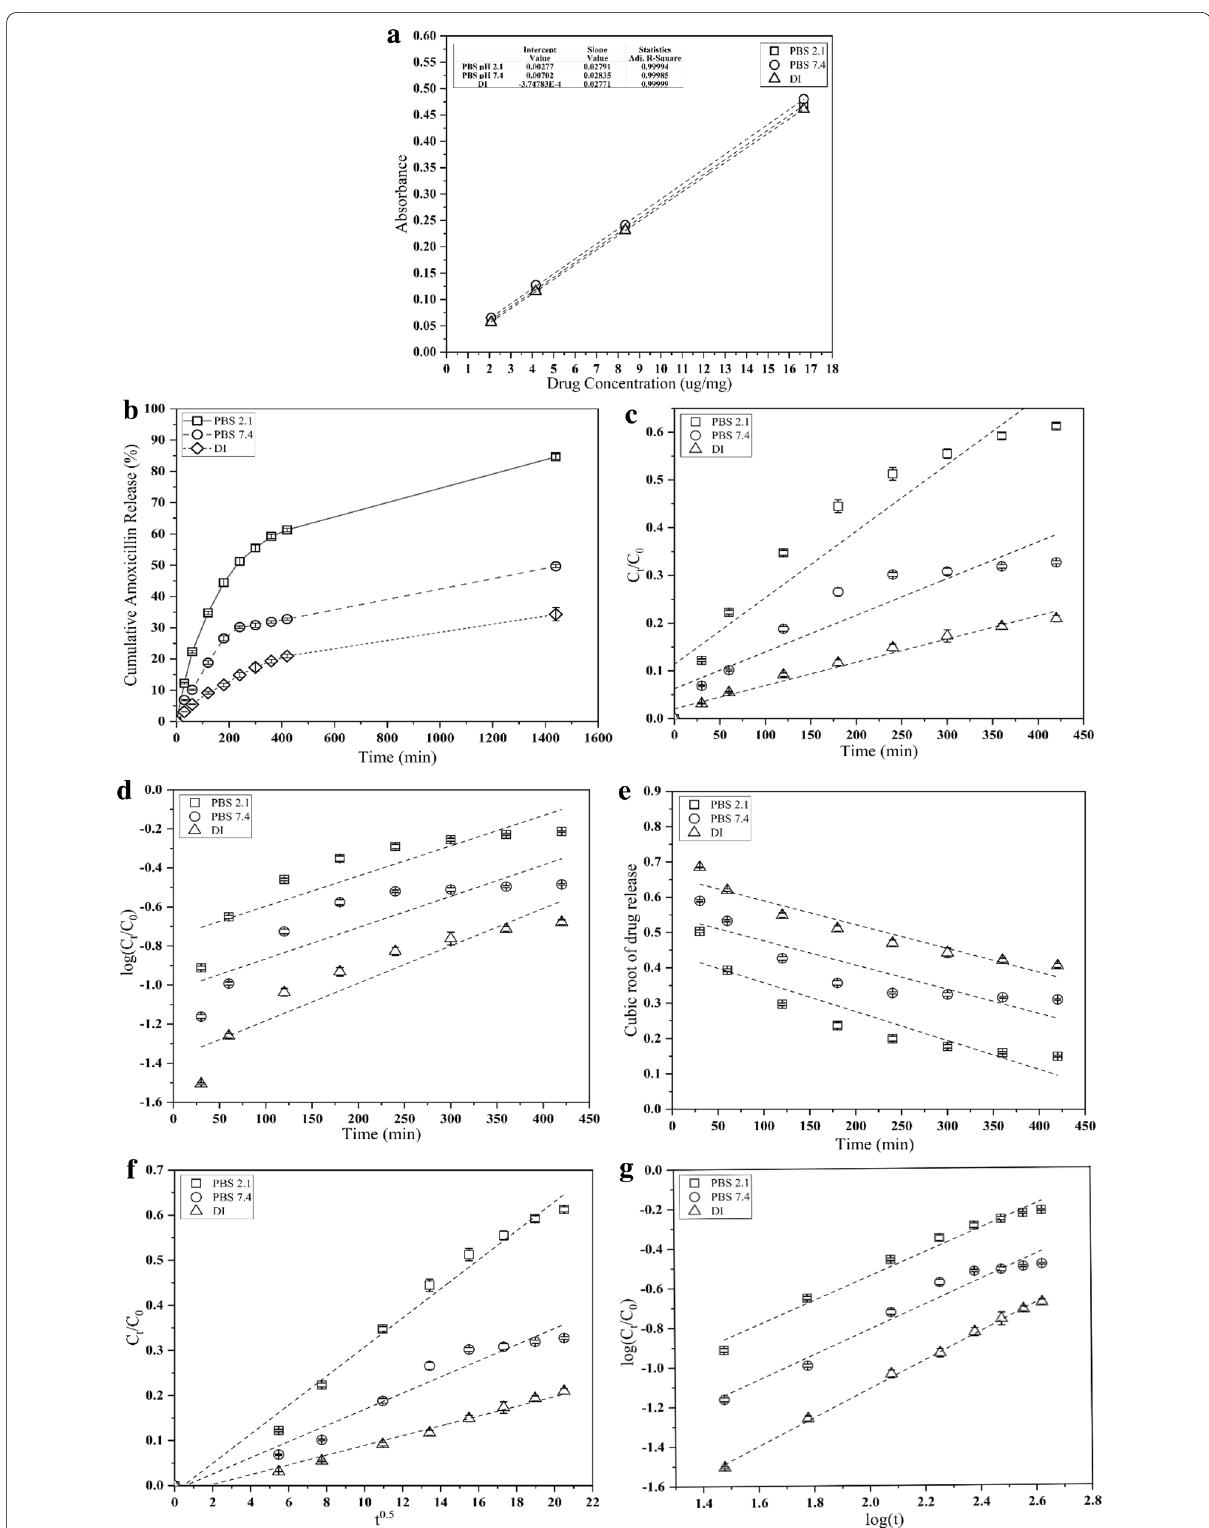
Fig. 7 a Calibration curve for Amoxicillin using UV-vis spectroscopy, b cumulative release of the 50/50 CS/PVA; the drug release profiles of CS/PVA 50/50 were calculated using the c zero-order, d first-order, e Hixson-Crowell model, f Higuchi model, and g Korsmeyer-Peppas